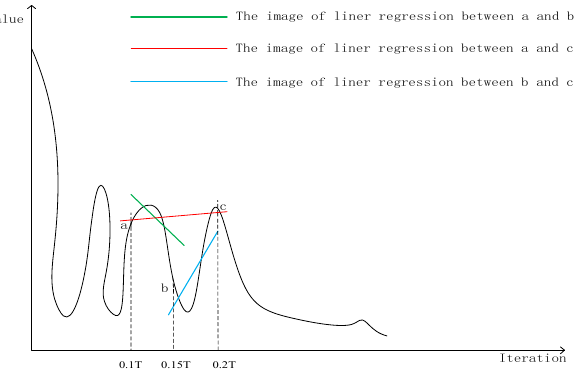
Figure 2. The illustration of the linear regression selection strategy.